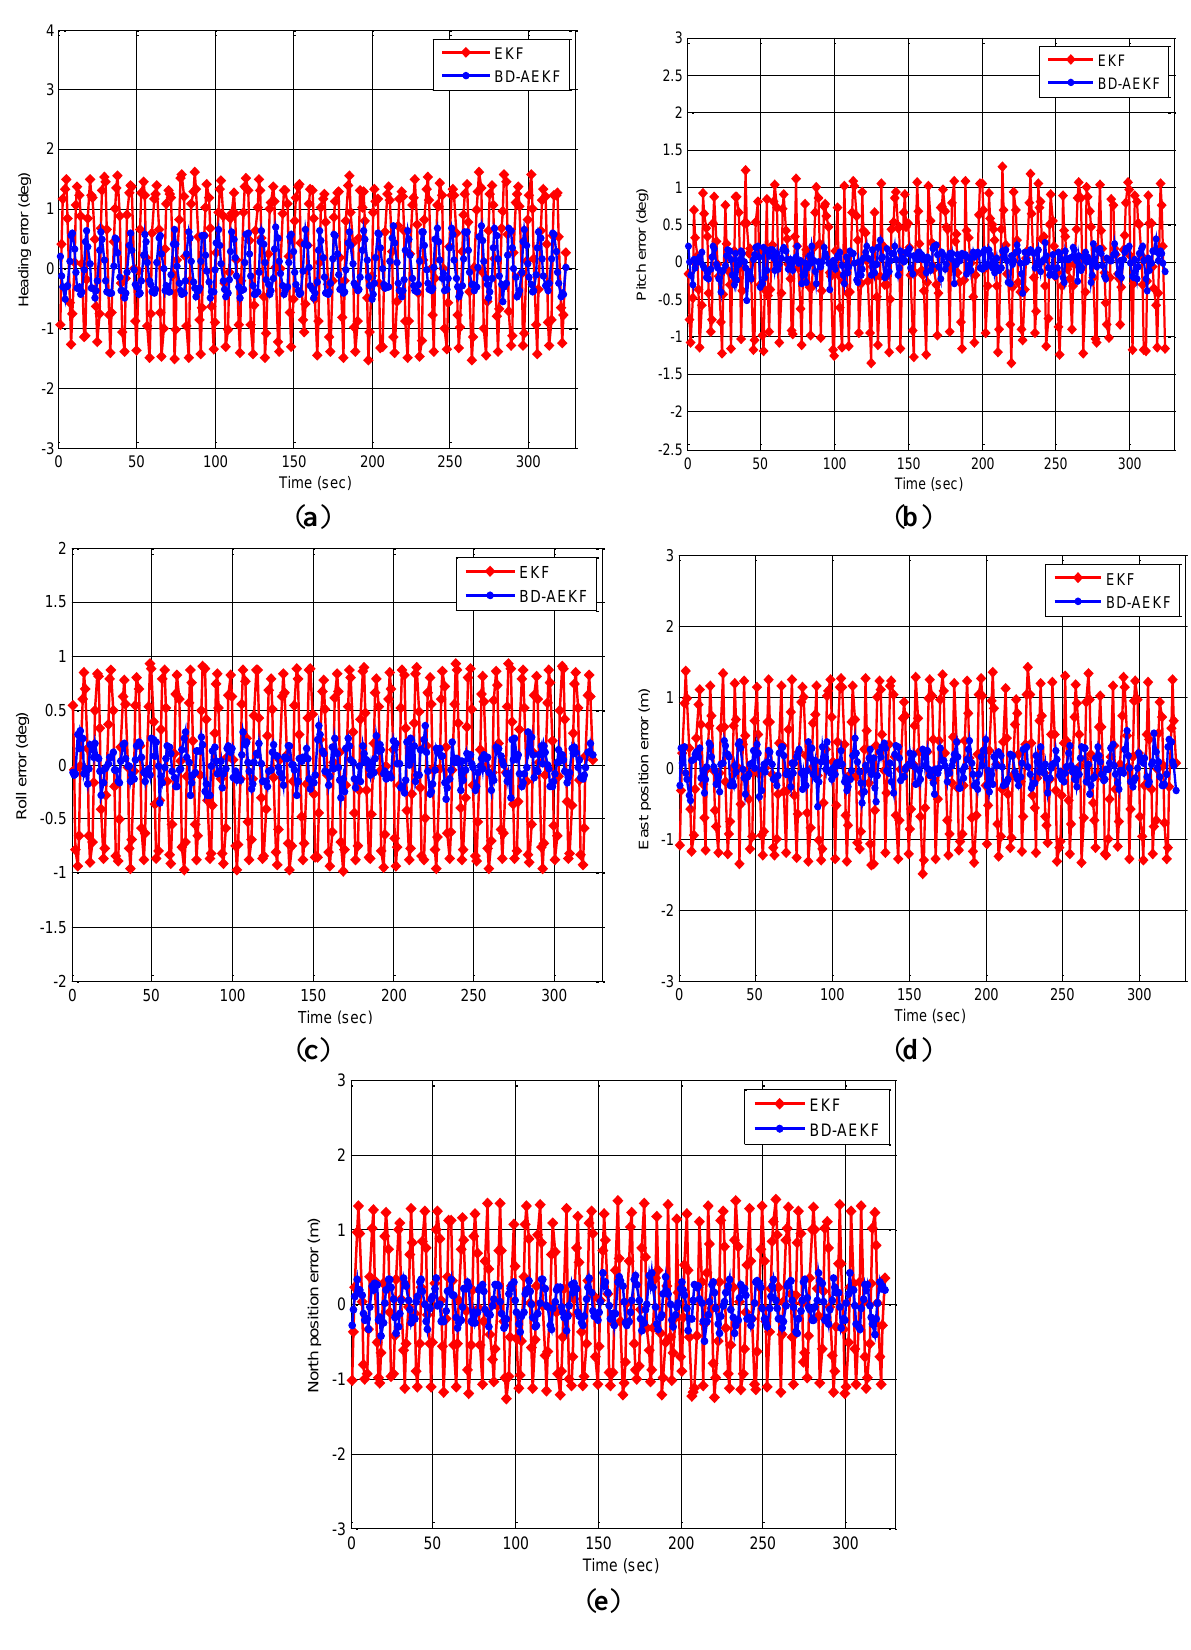
Figure 3. The attitude error and position error for EKF and BD-AEKF when the roll changes in the sine form. ( a ) Heading ( b ) Pitch ( c ) Roll ( d ) East position ( e ) North